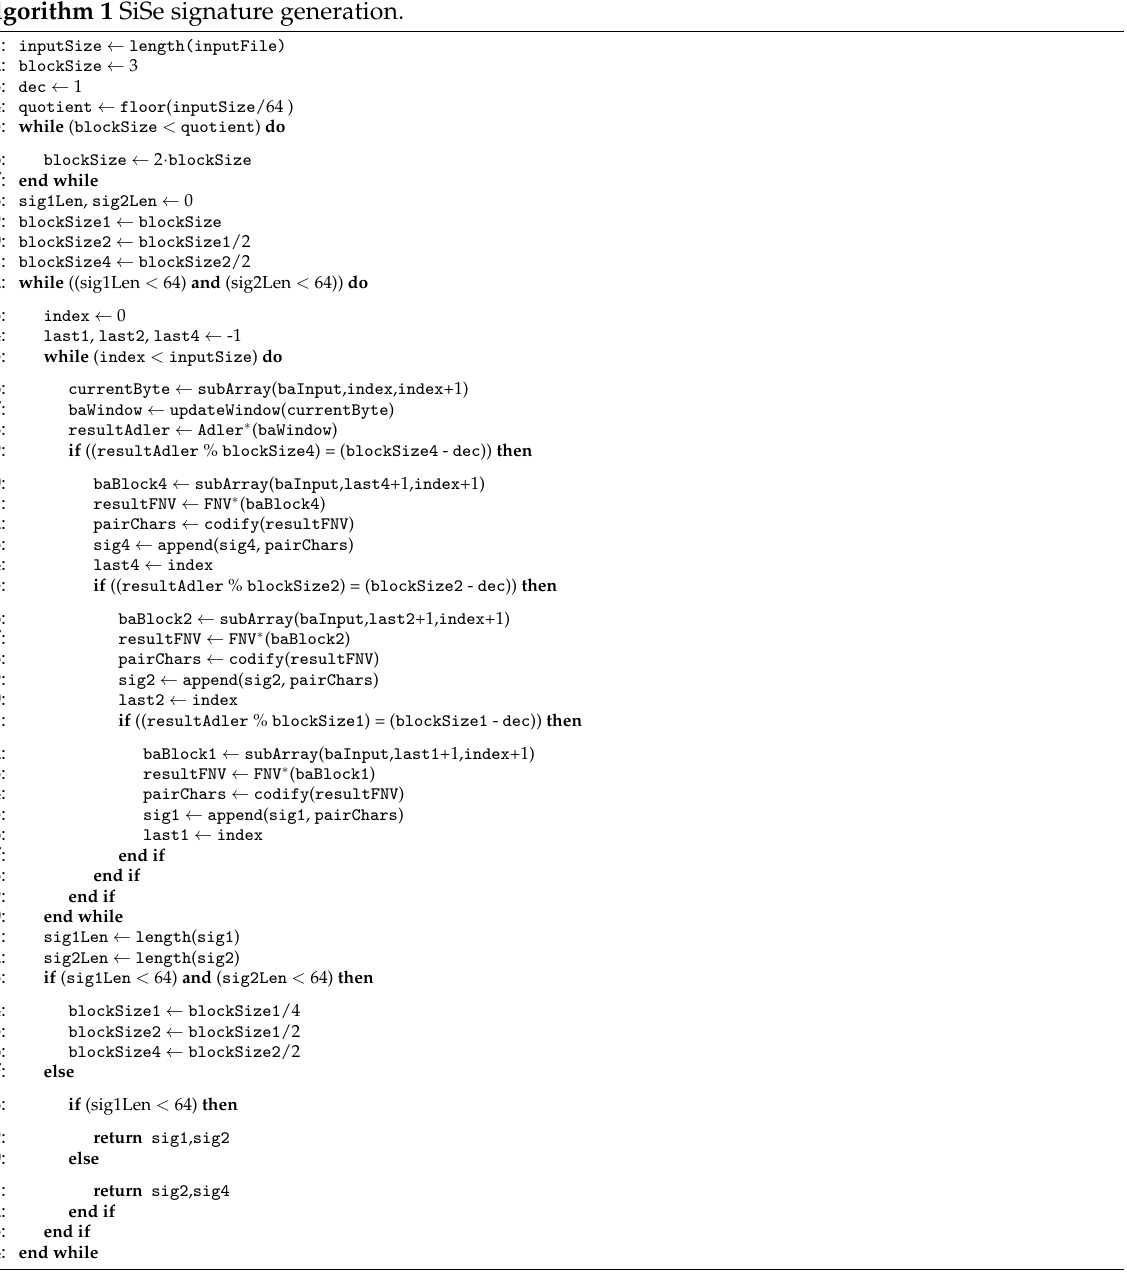
Algorithm 1 SiSe signature